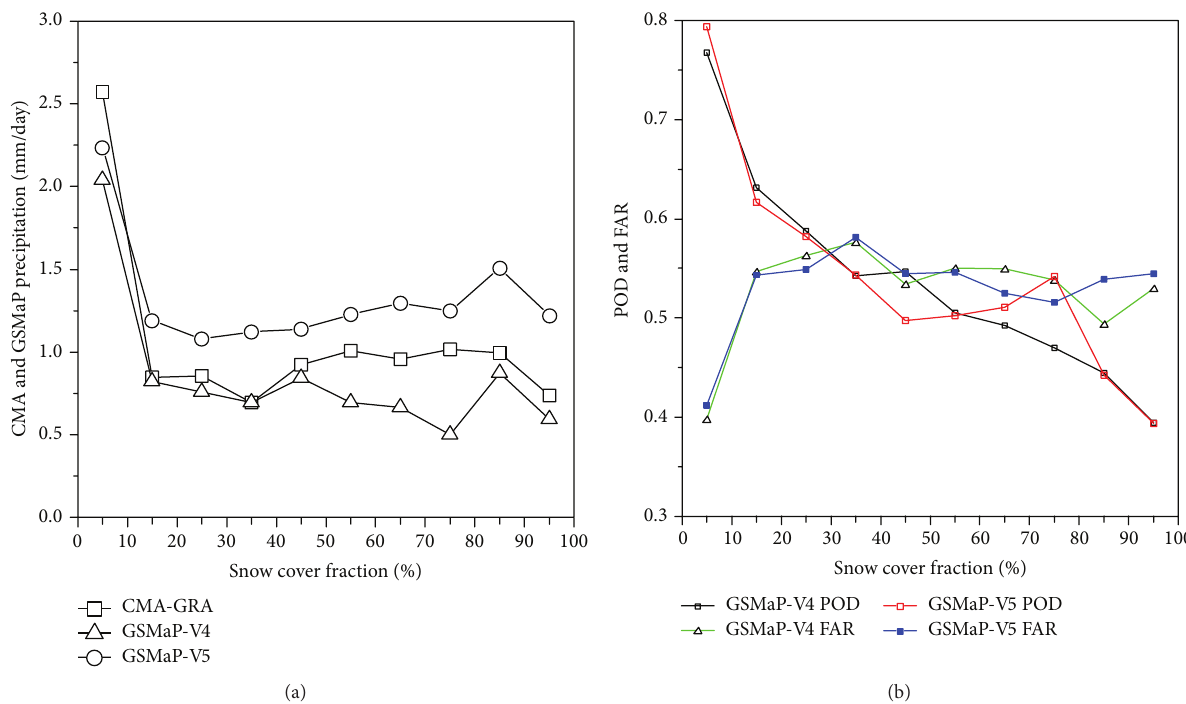
Figure 9: Relationship between statistics of GSMaP and snow cover fraction. (a) CMA and GSMaP precipitation amount. (b) POD and FAR.